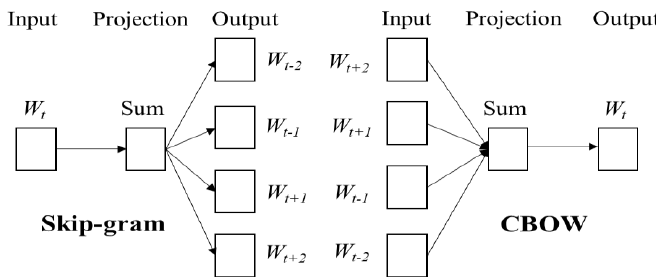
Figure 3. The schematic diagram of skip-gram and CBOW models.